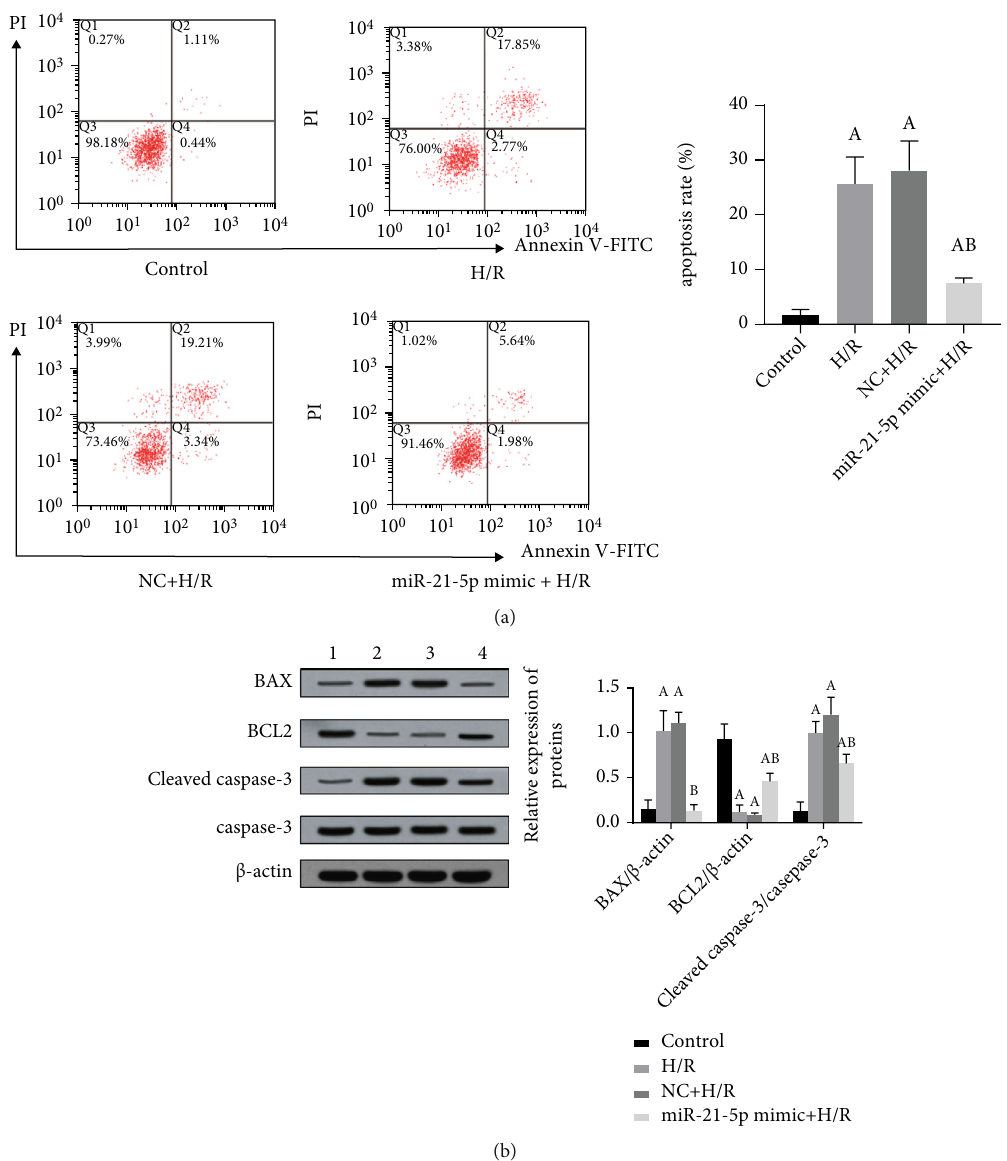
Figure 3: The e ff ect of miR-21-5p overexpression on H/R-induced apoptosis ( n = 3 ). (a) Under H/R conditions, the e ff ect of overexpression of miR-21-5p in HT22 cells on cell apoptosis; (b) under H/R conditions, changes in the expression of apoptosis-related proteins in cells overexpressing miR-21-5p. The experimental groups are as follows: 1: control group; 2: H/R group; 3: NC+H/R group; 4: miR-21-5p mimic+H/R group. Note: Student ’ s t -test was used. Compared with the control group, a P < 0 : 05 ; compared with the H/R group, b P < 0 : 05